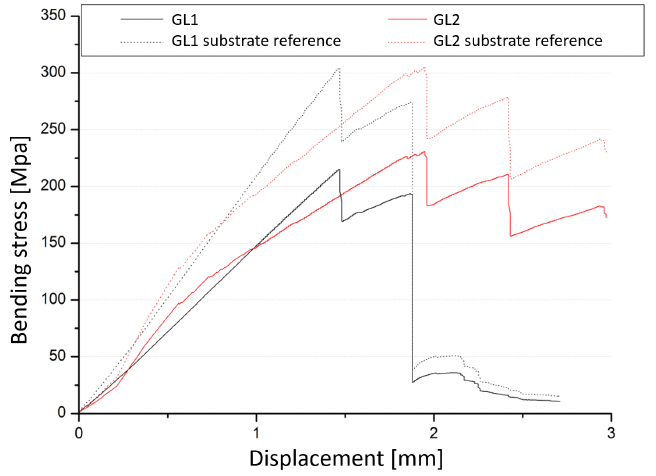
Figure 13. In bending tests determined bending stress in dependence of the deflexion for two samples and two reference square sections